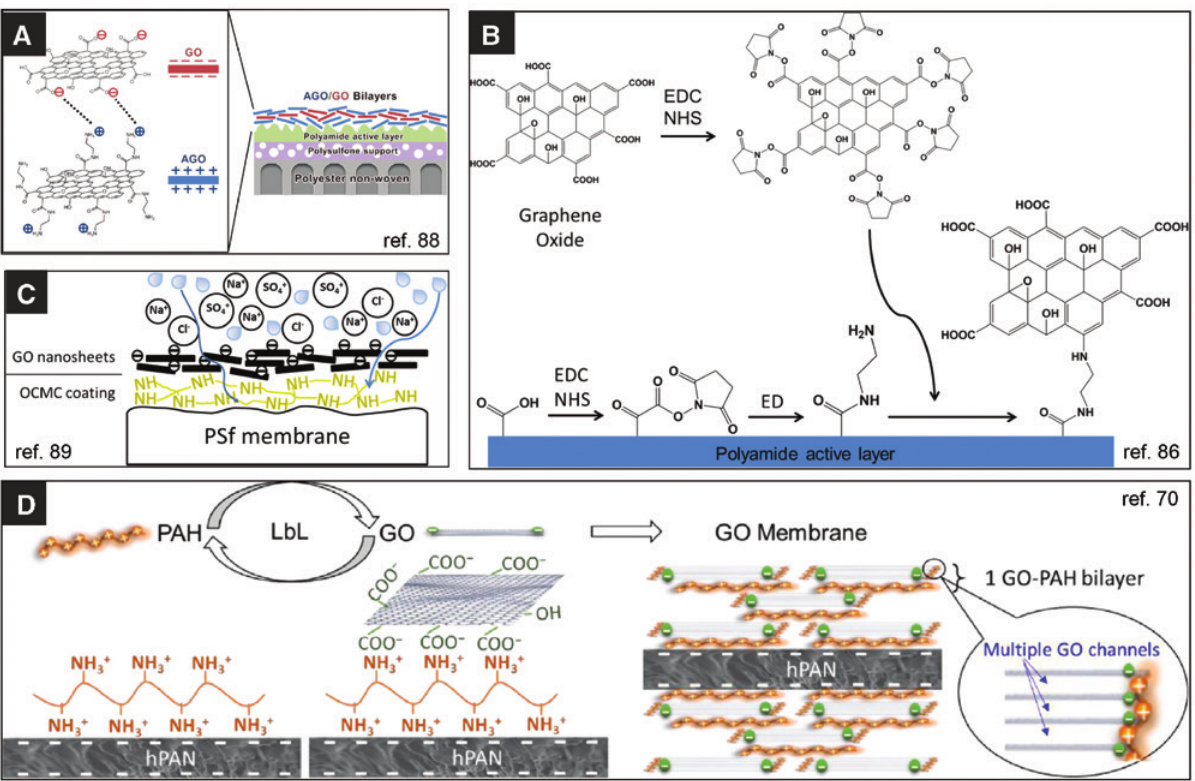
Figure 5: Surface functionalization of membranes with GO proposed by several authors. (A) Electrostatic assembly of oppositely charge functionalized GO. (B) Amino coupling of N-hydroxysuccinimide functionalized GO. (C) Electrostatic adsorption of GO. (D) Polyelectrolyte- aided layer-by-layer assembly of